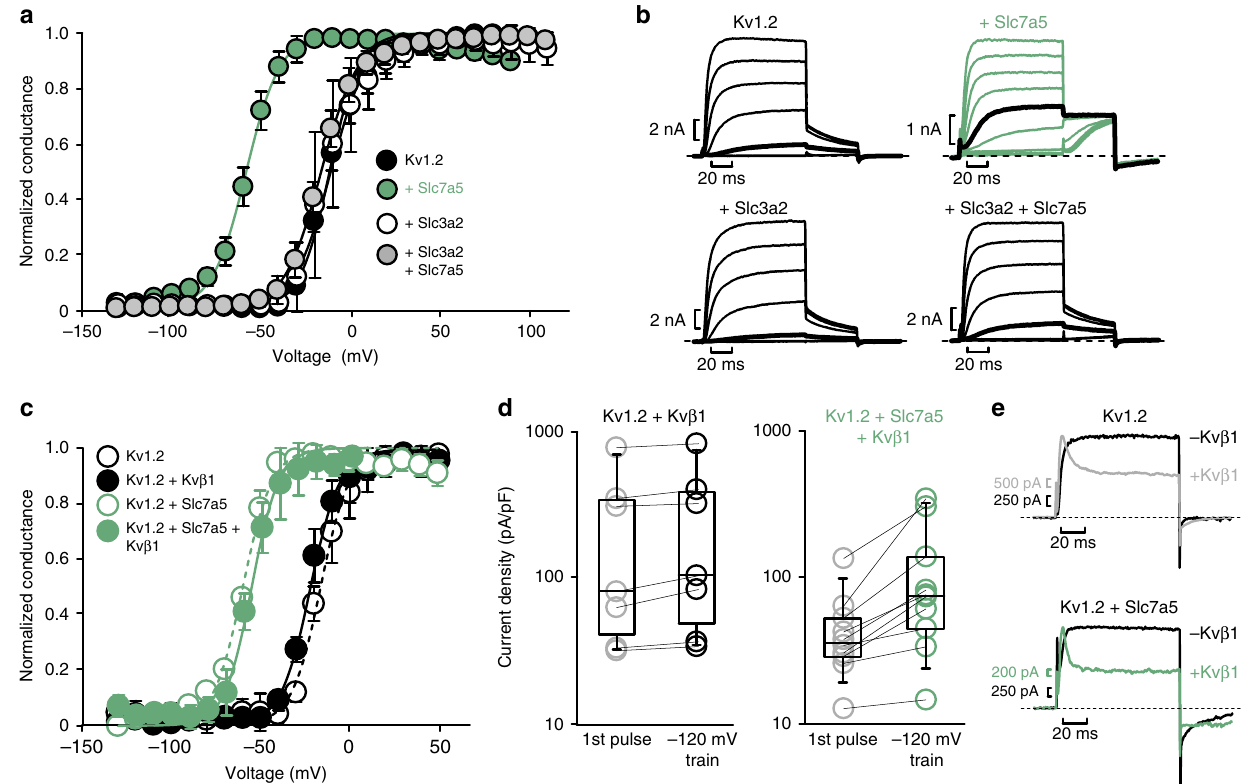
Fig. 4 Slc7a5 shifts the voltage-dependence of Kv1.2 activation. a Indicated combinations of Kv1.2, Slc7a5, and Slc3a2 were transfected in ltk- mouse fi broblasts. Cells were hyperpolarized to − 120 mV for 30 s prior to recording, leading to disinhibition of Kv1.2 currents. Conductance-voltage relationships were measured as described in Fig. 1. Conductance-voltage relationships were generated from the tail current amplitudes and fi t with a Boltzmann function (Kv1.2 V 1/2 = − 11 ± 3, k = 11 ± 3 mV, n = 5; Kv1.2 + Slc7a5 V 1/2 = − 58 ± 3, k = 10 ± 2 mV, n = 16; Kv1.2 + Slc3a2 V 1/2 = − 11 ± 10, k = 10 ± 3 mV, n = 10; and Kv1.2 + Slc7a5 + Slc3a2 V 1/2 = − 16 ± 3 mV, k = 11 ± 2 mV, n = 9). b Representative traces of the activation curves measured in a , with the pulse to − 20 mV highlighted. c HEK cells were transfected with equal amounts of the indicated combinations of Kv1.2, Slc7a5, and Kv β 1.3. Conductance-voltage relationships were generated as in a (Kv1.2 V 1/2 = − 16 ± 3, k = 9 ± 4 mV; Kv1.2 + Kv β V 1/2 = − 22 ± 4, k = 9 ± 2 mV; Kv1.2 + Slc7a5 V 1/2 = − 60 ± 1, k = 9 ± 1 mV; and Kv1.2 + Slc7a5 + Kv β V 1/2 = − 56 ± 3 mV, k = 9 ± 3 mV). d Current density at + 10 mV was measured at the beginning and of a pulse train with a − 120 mV holding potential (identical to Fig. 3; Kv1.2 + Kv β n = 7; Kv1.2 + Kv β + Slc7a5 n = 11). e Representative traces illustrating N-type inactivation conferred by Kv β in the presence and absence of Slc7a5 (100 ms step from − 80 mV to + 60